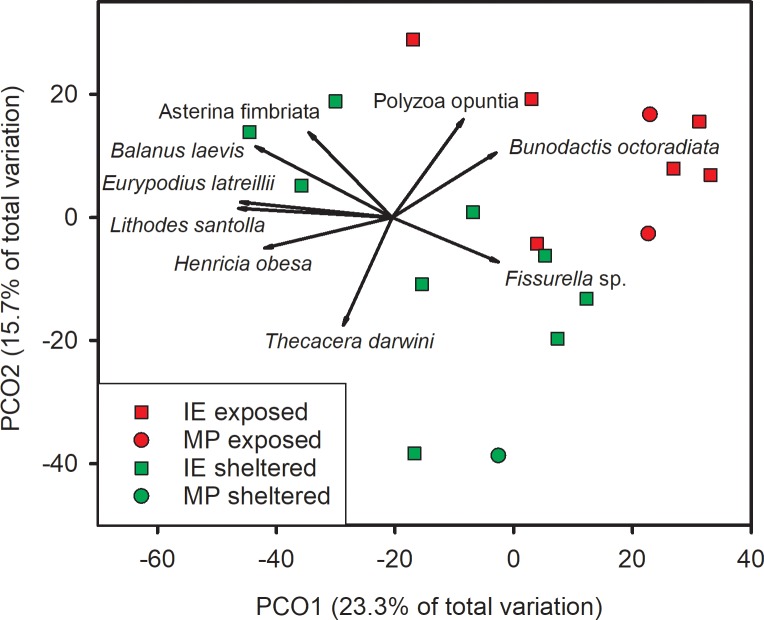
Principle coordinates analysis of benthic invertebrate community composition based on density (number of individuals.m-2) by location and exposure.Data were ln(x+1)-transformed prior to analyses. Vectors are the relative contribution and direction of influence of benthic components to the observed variation among sites (Pearson Product movement ≥ 0.5).